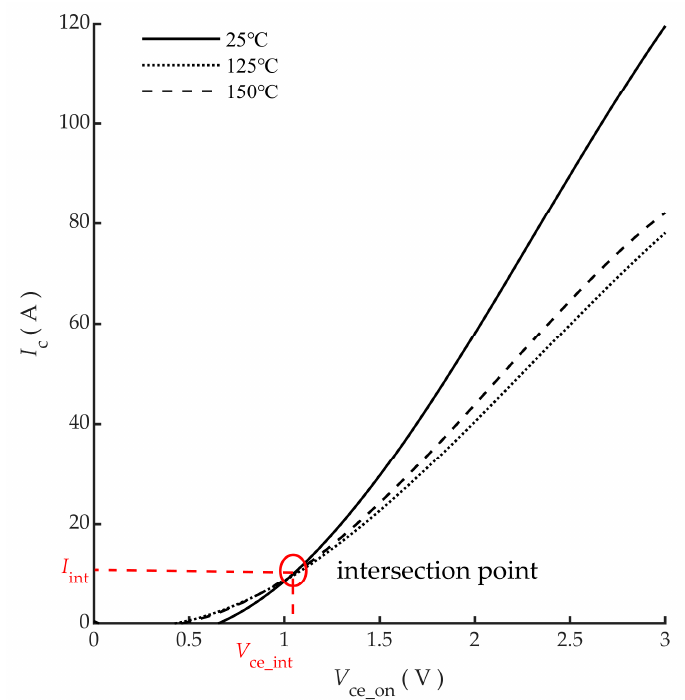
Figure 2. IGBT output characteristic curve.